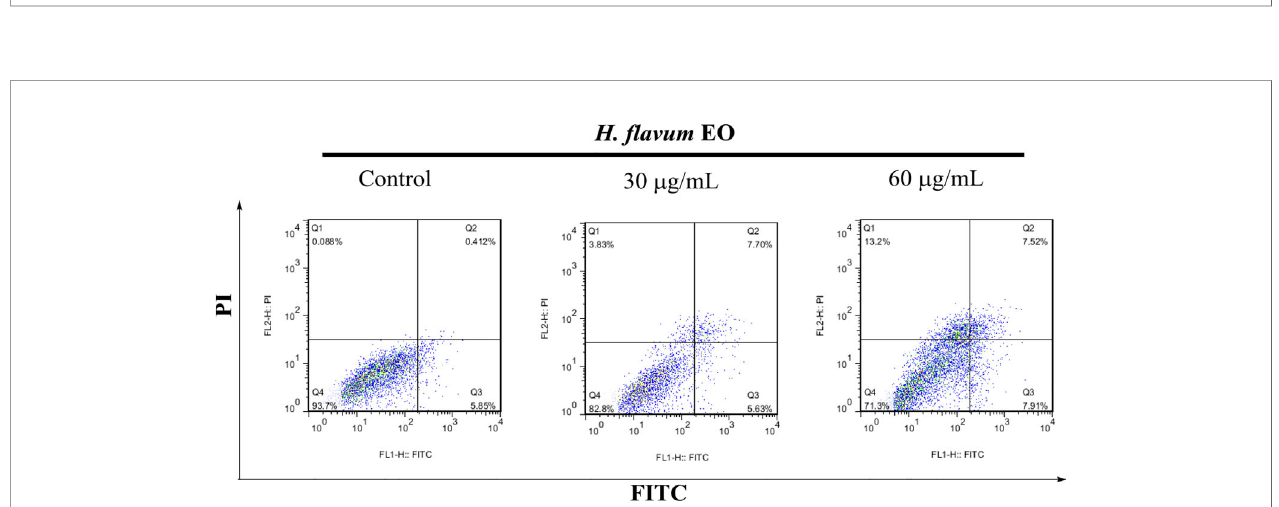
FIGURE 5 | Apoptosis analysis of K562 cells treated with H. fl avum EO using a fl ow-cytometer. Cells in upper left quadrant (Q1-UL: AV – /PI+): necrotic cells; upper right quadrant (Q2-UR: AV+/PI+): late apoptotic cells; lower right quadrant (Q3-LR: AV+/PI – ): early apoptotic cells; lower left quadrant (Q4-LL: AV – /PI – ): live